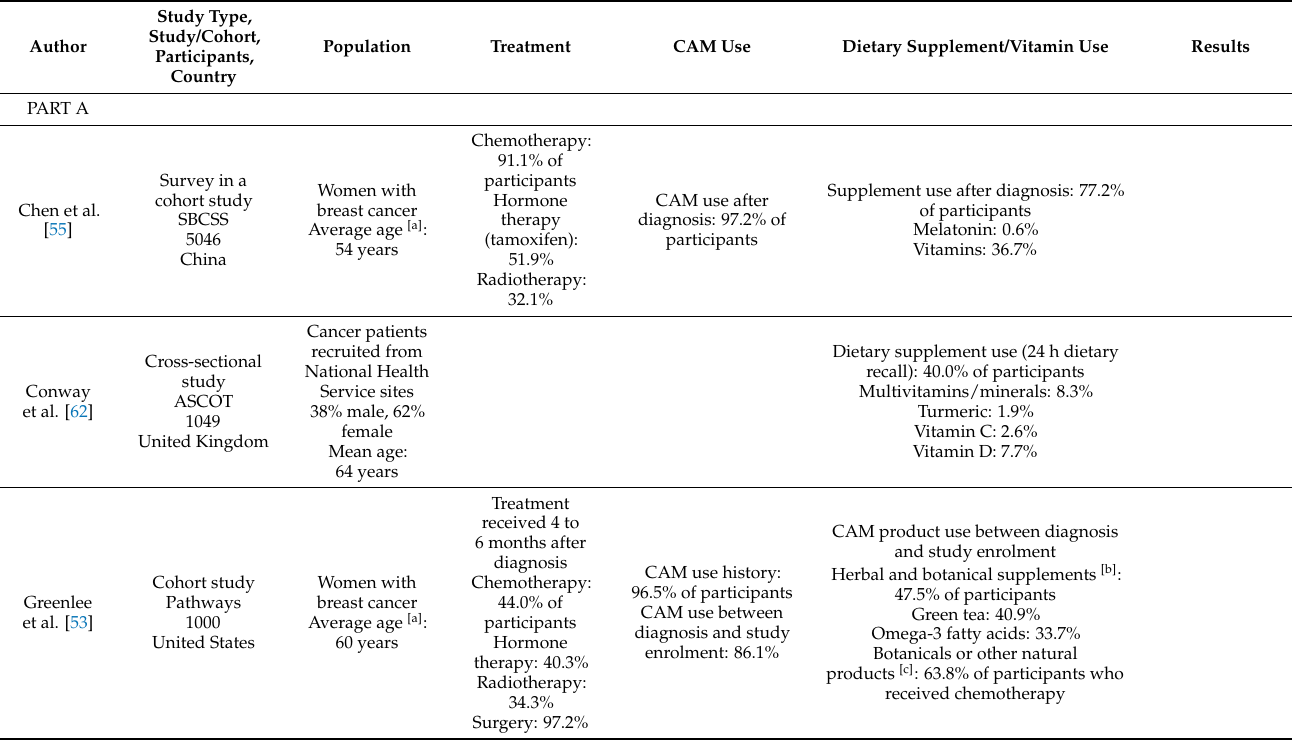
Table 1. Results of the systematic literature review on CAM, dietary supplement, and vitamin use among cancer patients.